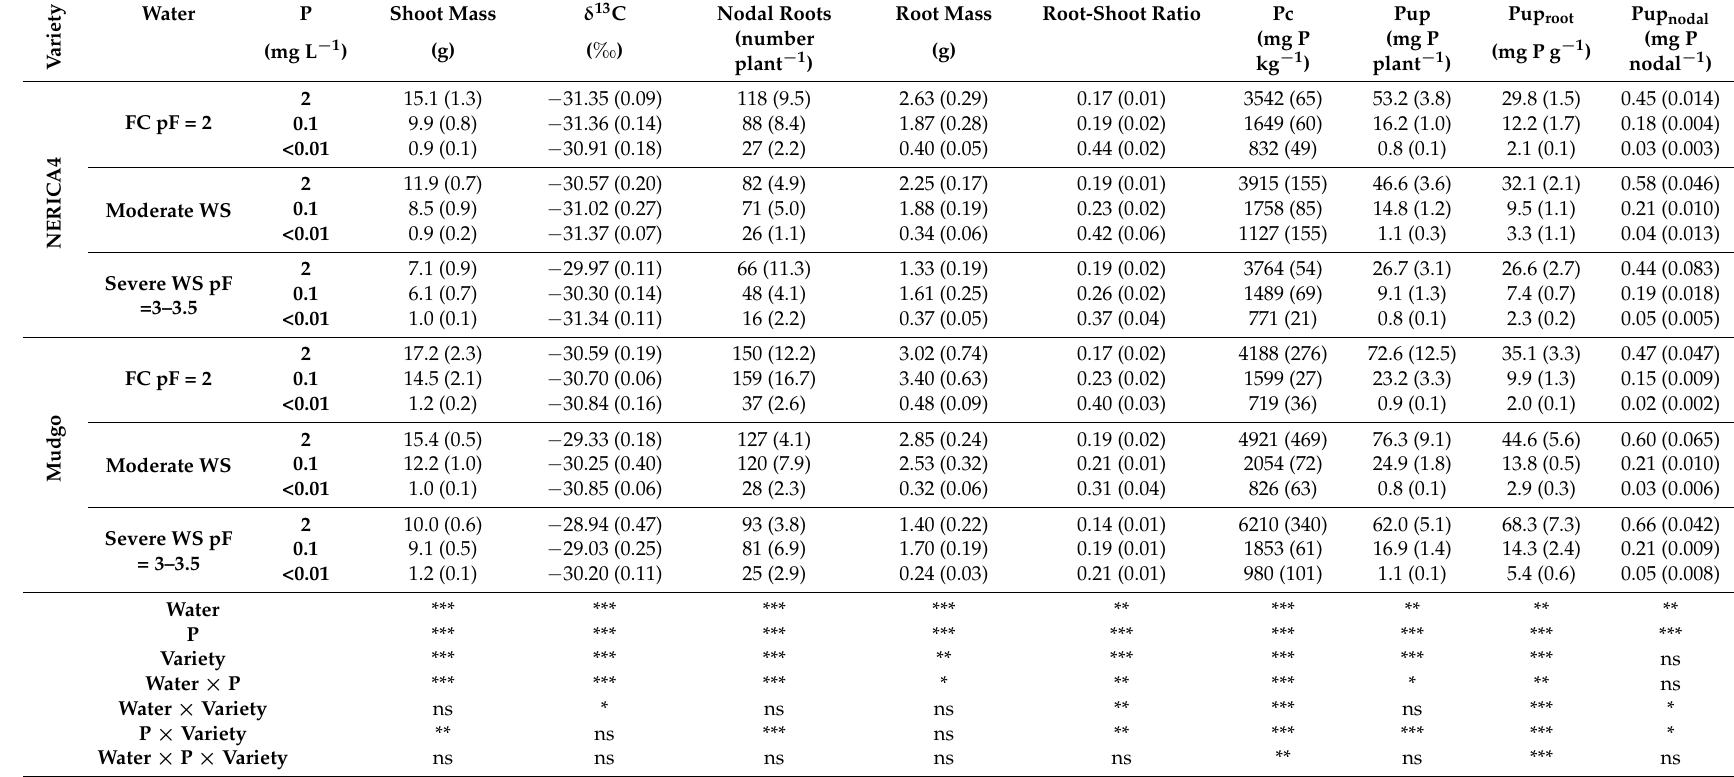
Table 5. Shoot, root, carbon isotope discrimination, and P uptake data from two varieties grown in a pot trial using the upland soil to which P was applied to achieve P concentrations in soil solution of <0.01 mg L − 1 , 0.1 mg L − 1 , and 2 mg L − 1 . Water supply was managed to achieve: Severe water stress (severe WS), moderate water stress (moderate WS) and field capacity (FC). Data are presented as means with (standard errors). Probabilities of F-statistics for the treatment effects are presented at the bottom of the table. (Pc = Shoot P concentration; Pup = Total P uptake by the shoot; Pup root = Shoot P uptake per unit root weight; Pup nodal = Shoot P uptake per nodal